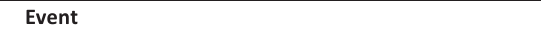
Table 3. Summary of events during periods of High Hurst